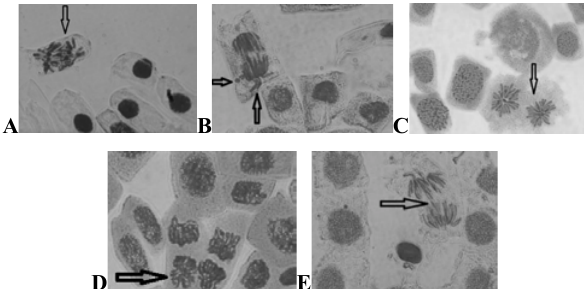
Fig. 2. Some chromosomal aberrations identified in meristematic cells of A. sativum exposed to Ni(NO 3 ) 2 and Pb(NO 3 ) 2 : C-Mitosis (A), fragments and vagrants (B), star-telophase (C), stickiness in telophase (D), anaphase bridge